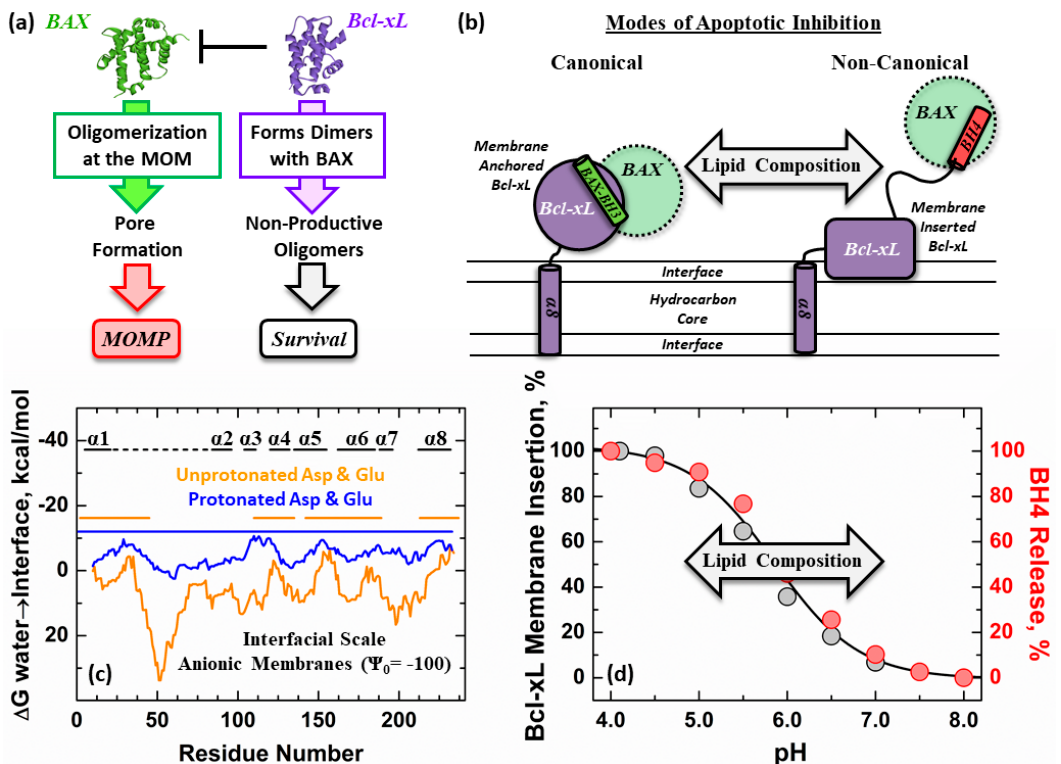
Figure 1. Conformational switching of Bcl-xL in membranes, resulting in conversion from canonical to non-canonical forms of apoptotic inhibition. ( a ) The anti-apoptotic protein Bcl-xL (purple) binds to the pore former BAX (green) to block the permeabilization of the mitochondrial outer membrane (MOM) and prevent apoptosis [3,4]. ( b ) Several molecular mechanisms, involving both membrane-anchored and membrane-inserted Bcl-xL, have been proposed to explain this process. The canonical mode (left) relies on the interaction of anchored Bcl-xL with the BH3 helix of BAX [7]; while in the non-canonical mode (right), BAX binds the N-terminal BH4 helix of refolded and inserted Bcl-xL. Lipid composition is hypothesized to modulate the transition between both inhibitory modes by facilitating the conformational switch between different conformations of Bcl-xL in the bilayer. ( c ) Bcl-xL hydropathy plot is presented for the two cases of either unprotonated (orange) or protonated (blue) titratable sidechains (D and E). This analysis was made using a modified version of the MPEx (http://blanco.biomol.uci.edu/mpex/) web tool [11], which accounts for both hydrophobic and electrostatic interfacial interactions [12]. The calculations were made assuming an approximate membrane surface potential ( Ψ 0 ) of -100 mV for a 1TOCL:2POPC bilayer, as described in Vasquez-Montes et al., 2019 [13]. Color-coded horizontal lines above the plot represent the regions of Bcl-xL predicted to interact with anionic membranes. The analysis showed a significant increase in the regions predicted to partition to the interface of anionic bilayers under protonating conditions with the largest effect observed for the unstructured α 1-2 loop connecting the N-terminal BH4 ( α 1) helix to the rest of Bcl-xL. ( d ) Illustration of the lipid modulation of protonation-dependent membrane insertion and refolding of Bcl-xL from previously published data [13]. Relative insertion of Bcl-xL (grey symbols) is accessed by changes in fluorescence intensity of NBD (7-Nitrobenz-2-Oxa-1,3-Diazol-4-yl) attached to the N175C mutant. The refolding of Bcl-xL (red symbols) is accessed by steady-state FRET measurements of the release of its N-terminal BH4 helix. TOCL: 1,1,2,2-tetraoleoyl-cardiolipin; POPC: palmitoyl-oleoyl-phosphatidylcholine.